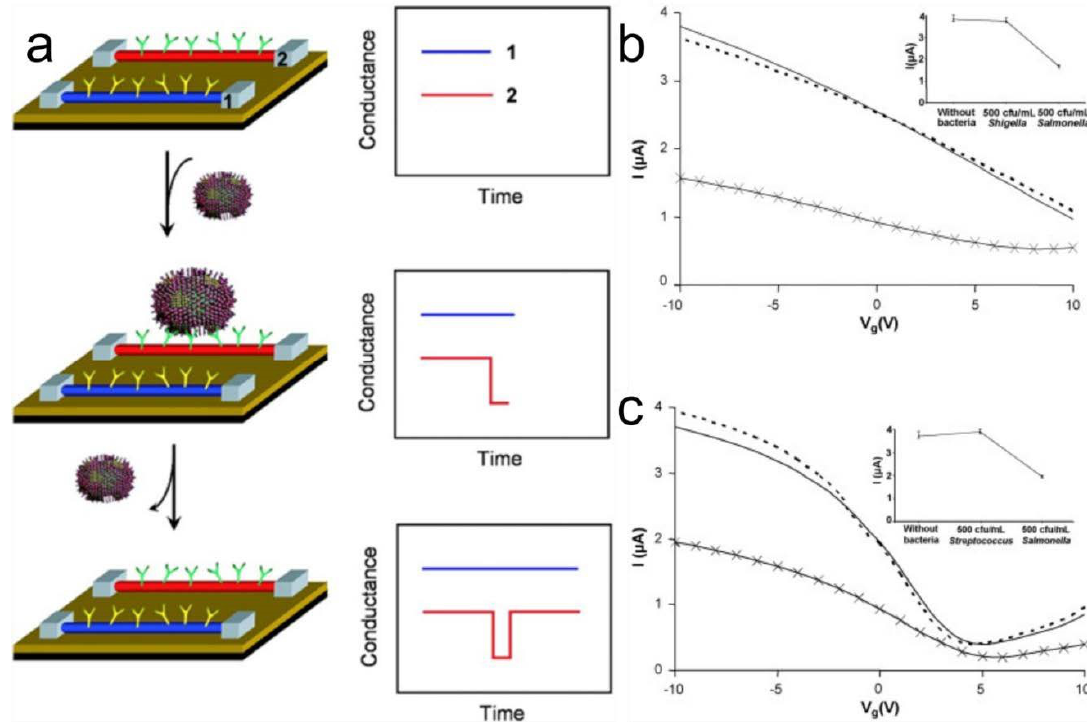
Figure 4. ( a ) Schematic illustration of the working principle of a CNT-based biosensors operating with a field-effect transistor configuration (CNT-bioFET). Only the CNT that are functionalized with the antibody receptor specific to the target virus can detect it, by producing a conductance change. The conductance can be restored when the virus unbinds from the surface. Reprinted from Ref. [63]. Copyright (2004) National Academy of Sciences. ( b ) Gate voltage dependence of the source-drain current of a functionalized CNT-bioFET before exposure to the bacteria (—) and after exposure to 500 cfu/mL of Shigella sonnei (- - - -) and 500 cfu/mL of Shigella Infantis (×). ( c ) Gate voltage dependence of the source-drain current of a functionalized CNT-bioFET before exposure to the bacteria (—) and after exposure to 500 cfu/mL of S. pyogenes (- - - -) and 500 cfu/mL of S. Infantis (×). Each electrical current plotted corresponds to the mean value of three replicates. The inset shows the behavior of the source-drain current at gate voltage = − 10 V. The error bars correspond to the range of the electrical current measured for the three replicates. Reprinted form Ref. [65] with permission from Elsevier.